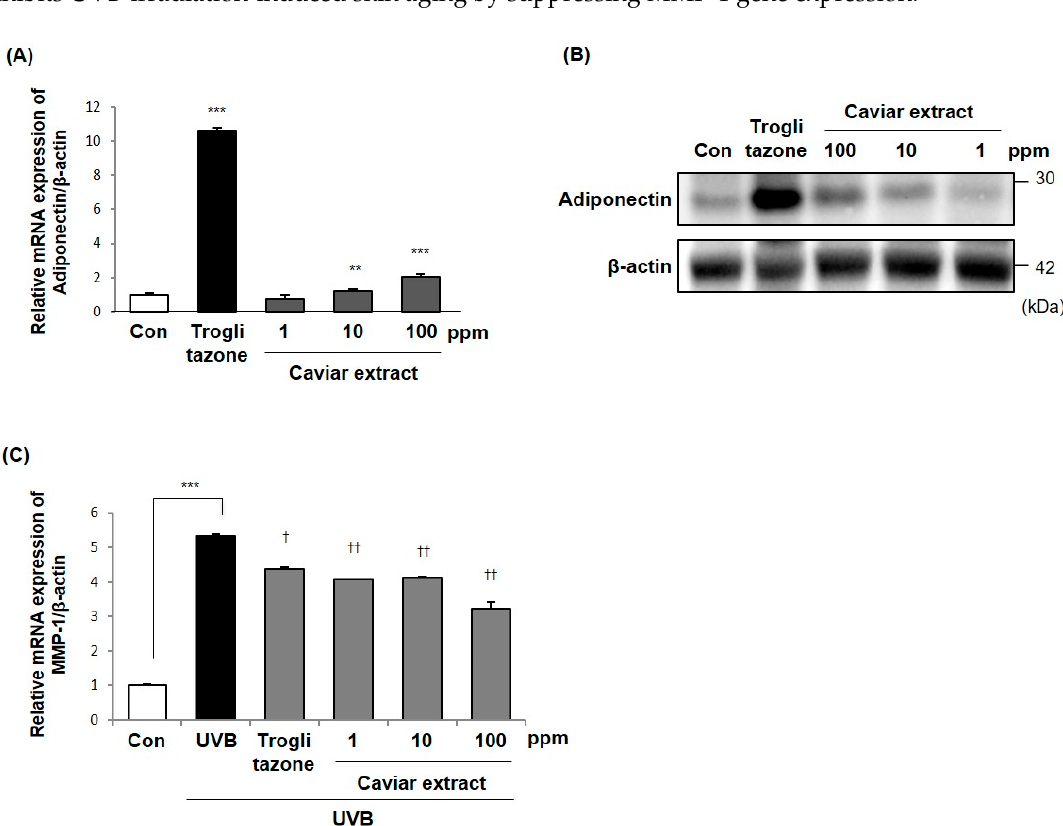
Figure 2. Caviar extract inhibited skin aging via an increase in adiponectin production. The 3T3-L1 cells were induced to di ff erentiate with or without treatment of caviar extract for 6 days. ( A ) Adiponectin mRNA and ( B ) adiponectin protein levels were measured by RT-qPCR and immunoblot, respectively. ( C ) The 3T3-L1 cells were di ff erentiated with caviar extract for 6 days, and the resulting conditioned medium was applied to UVB-irradiated Hs68 fibroblasts for 24 h. MMP-1 mRNA was then measured by RT-qPCR. The means ± SEs are the average of three independent experiments. ** p < 0.01, *** p < 0.001 compared to the control. † p < 0.05, †† p < 0.01 compared to the UVB-irradiated